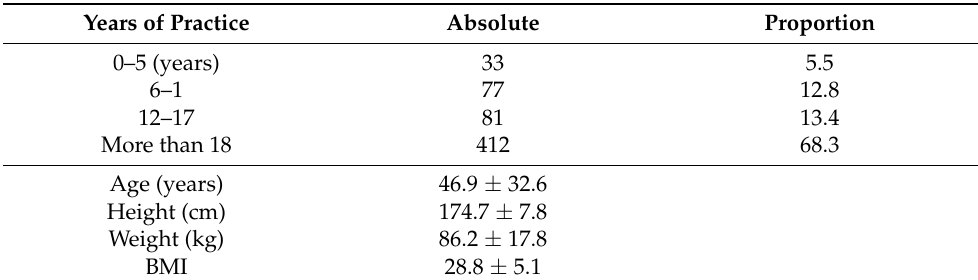
Table 2. Demographic data of the sample.